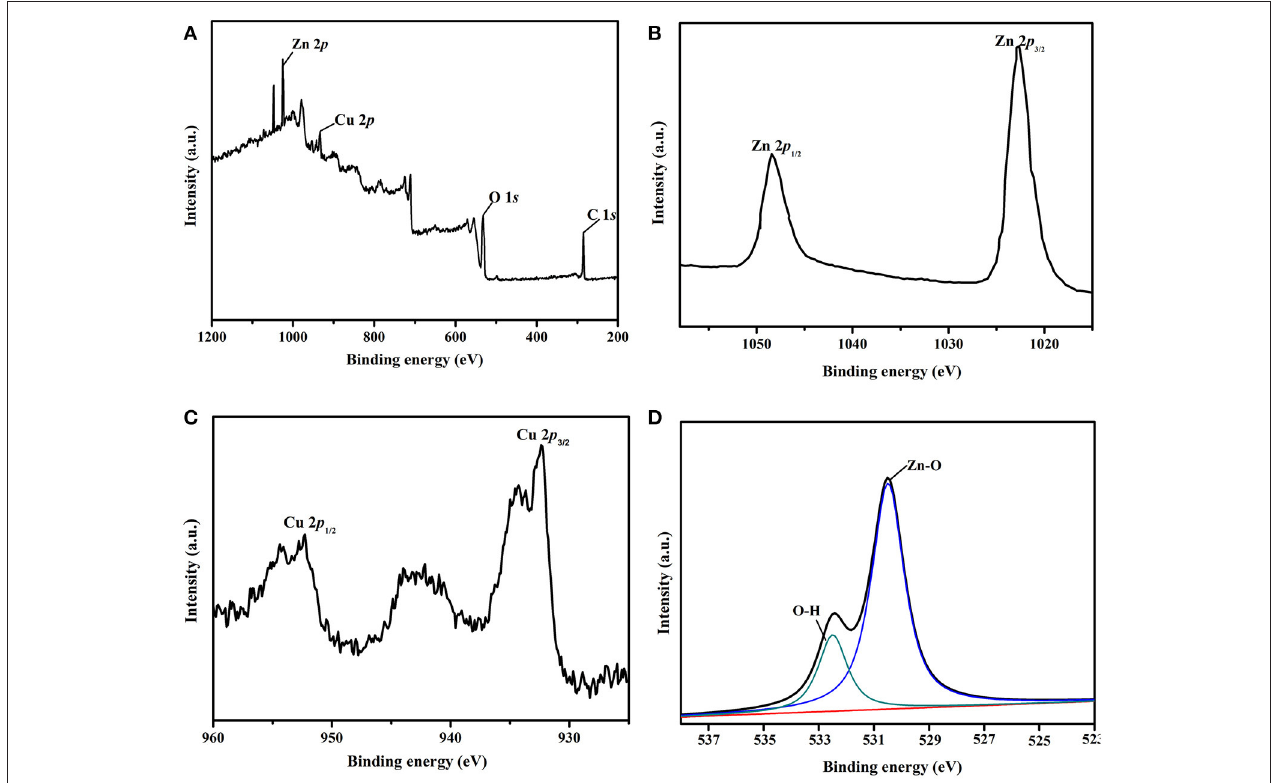
FIGURE 4 | (A) XPS spectrum of Cu/ZnO/rGO, (B) high-resolution spectrum of the Zn 2p region, (C) high-resolution spectrum of the Cu 2p region, and (D) and high-resolution spectrum of the O 1s region.